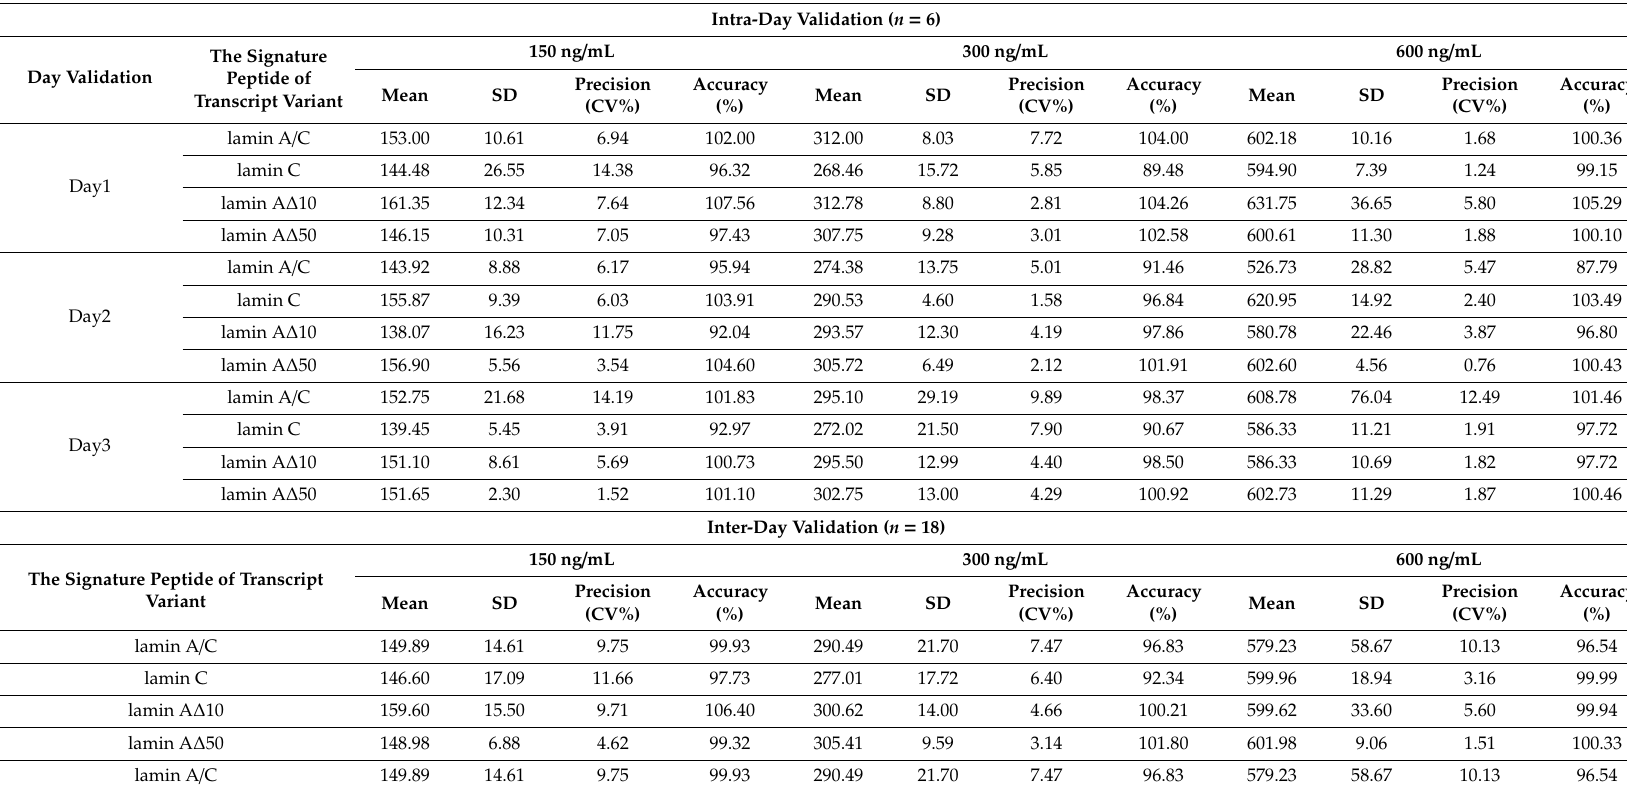
Table 3. Intra- and inter-day assays showed recorded values (RC), accuracy (RE%), and precision (CV%) of developed lamin method by LC–MS / MS